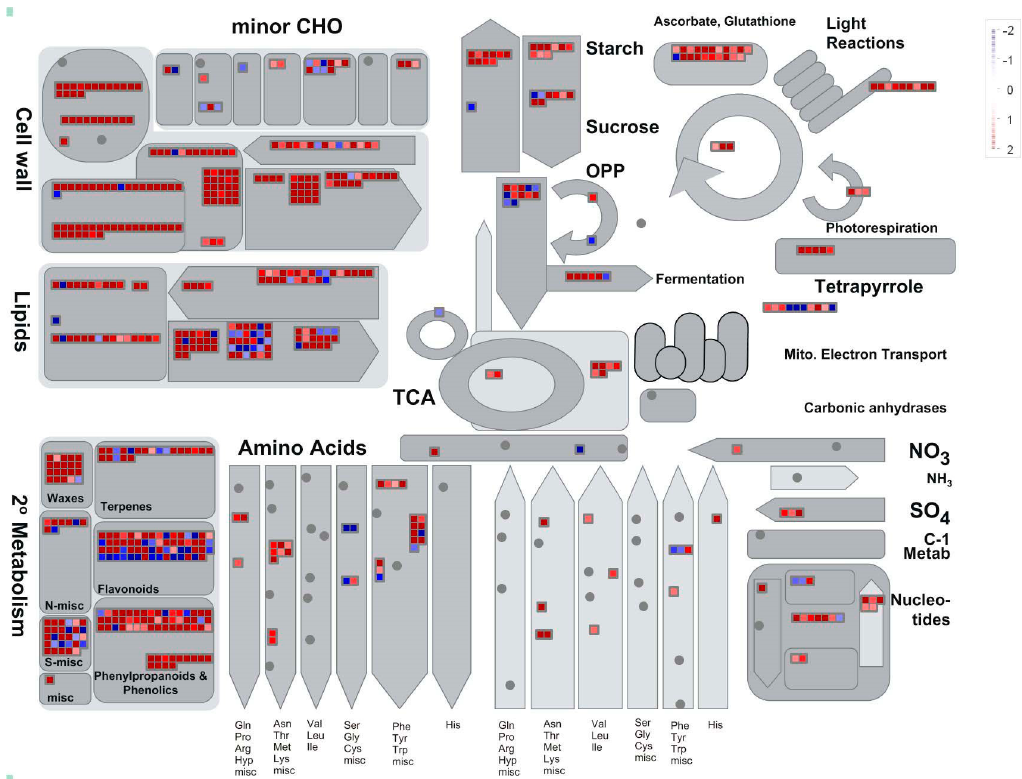
Figure 4. Global view of DEGs involved in diverse metabolic pathways. DEGs were selected for the metabolic pathway analysis using the MapMan software (V3.6.0RC2). The colored boxes indicate the log2 of expression ratio of DEGs. The DEGs could be mapped to 713 pathways by MapMan, of which 88 pathways were filtered and enriched by the dysregulated genes with a cutoff of p < 0.05. Table 4. The TF family and their contained dysregulated gene number. TF Family Up Gene Num. Down Gene